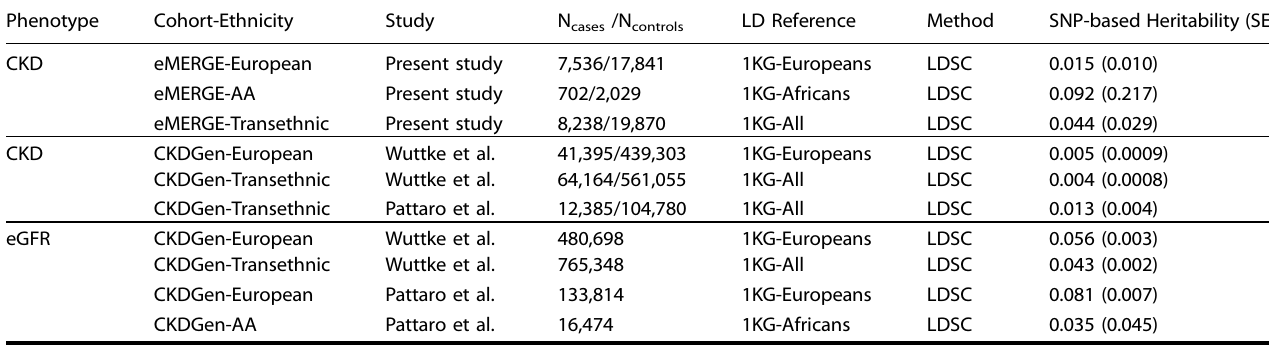
Table 4. SNP-based Heritability Estimates for CKD and renal